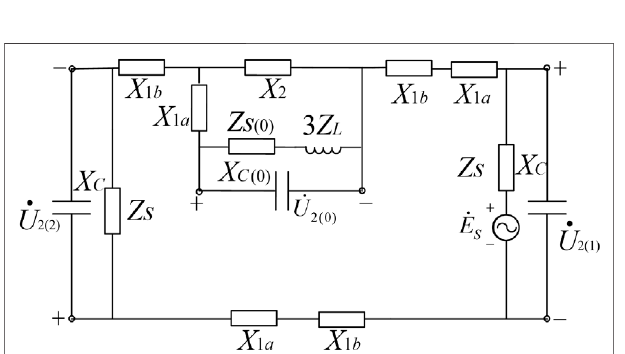
FIGURE 3 | Equivalent sequence diagram of the system.